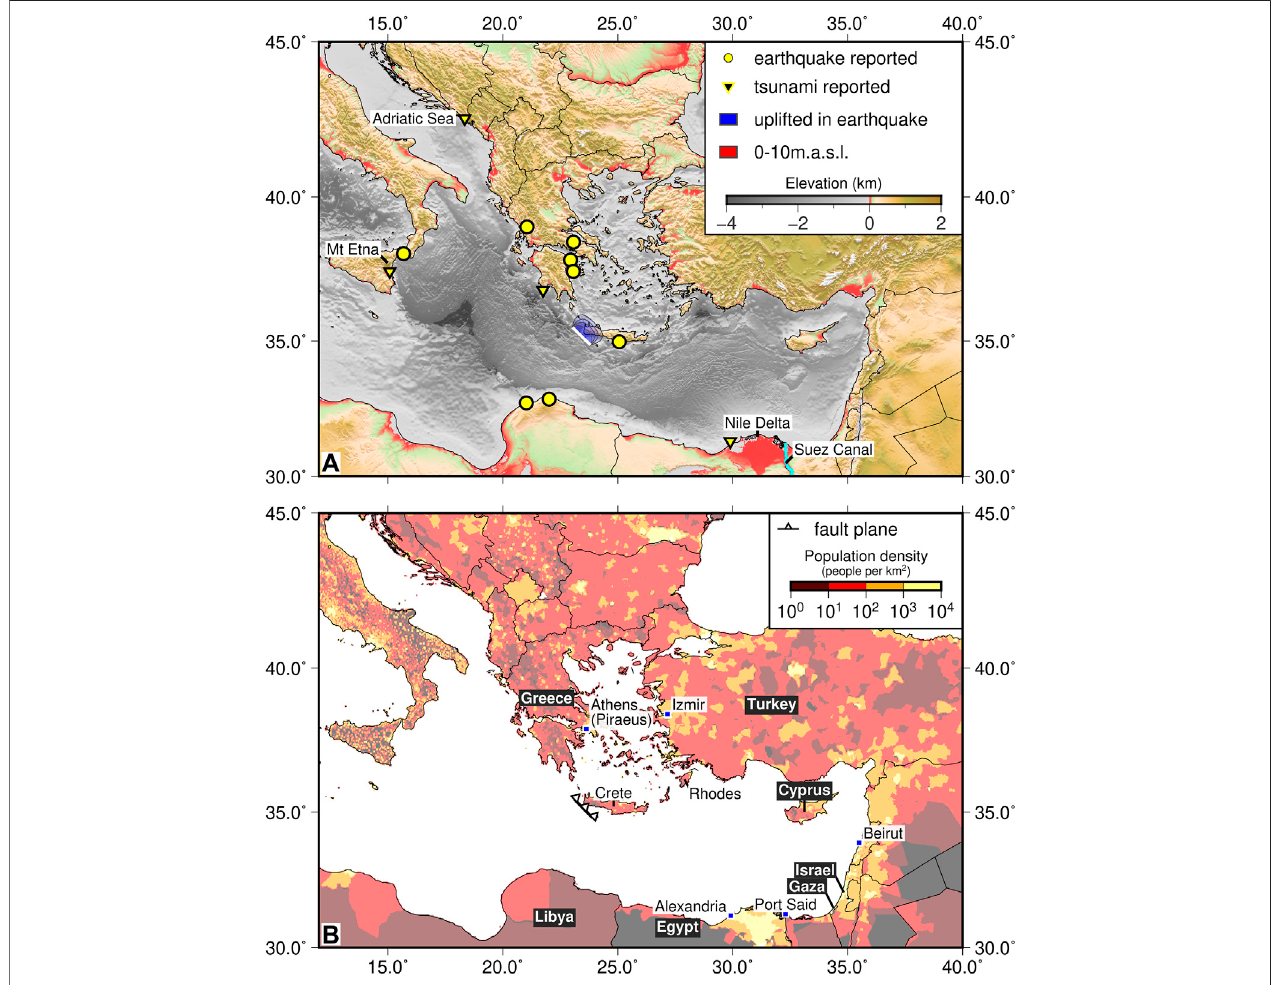
FIGURE 1 | Map of the 365CE earthquake and locations referenced in the text. (A) Map showing topography of Eastern Mediterranean. Uplift due to the 365CE earthquake on the fault plane proposed by Shaw et al. (2008) is shown by blue shading (darker blue indicates greater uplift, contours are spaced at 2 m uplift from 1 to 9 m). Yellow circles show locations where earthquake shaking was reported, inverted triangles show locations of tsunami inundation (Shaw et al., 2008; Ambraseys, 2009).Redregionsarelessthan10 mabovesealevel.ThecyanlineshowsthelocationofthepresentdaySuezCanal. (B) Mapshowingcontemporarypopulation density (from Center for International Earth Science Information Network - CIESIN - Columbia University, 2018) around the Mediterranean (note the logarithmic colour scale), and locations mentioned in the text. Blue squares show cities. The surface projection of the fault plane proposed by Shaw et al. (2008) is shown with teeth on the hanging wall side of the fault, which is expected to move more in an